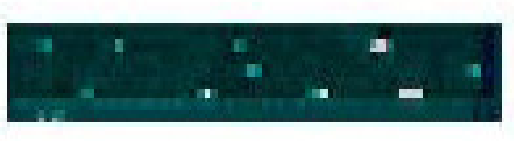
Figure 17: Bright Vehicle Detected Image